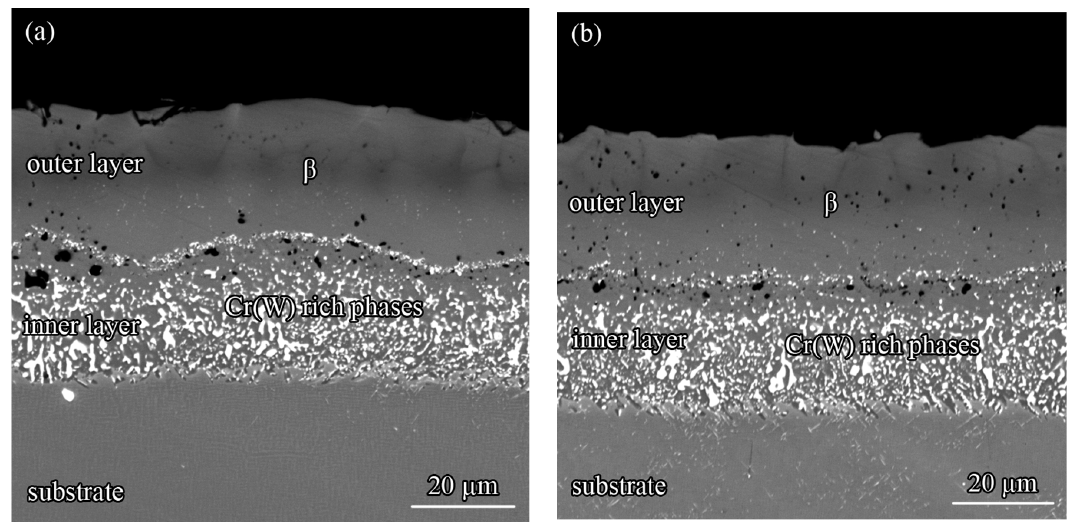
Figure 3. Cross-sectional morphologies of the coatings before oxidation: ( a ) PtAl and ( b ) PtSiAl.